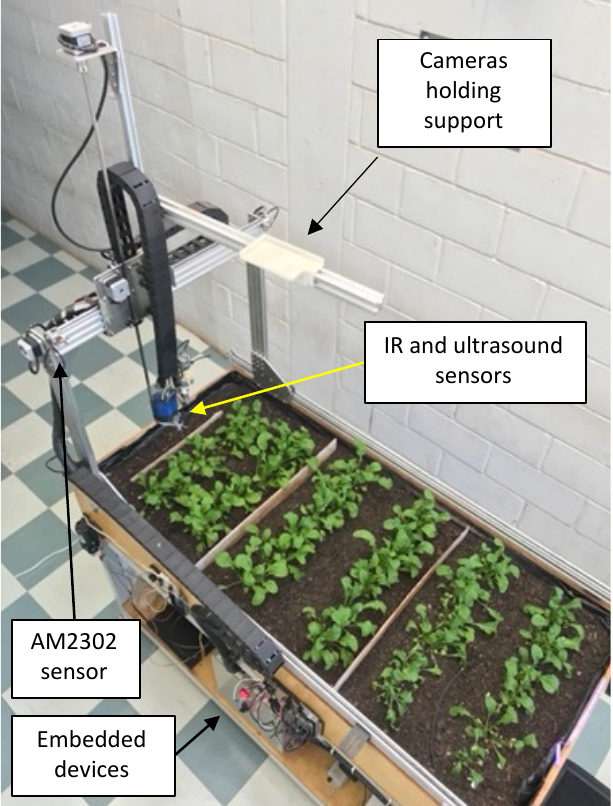
Figure 2. Schematic of the bench test, showing the arrangement of sets of sensors to detect water stress through CWSI.